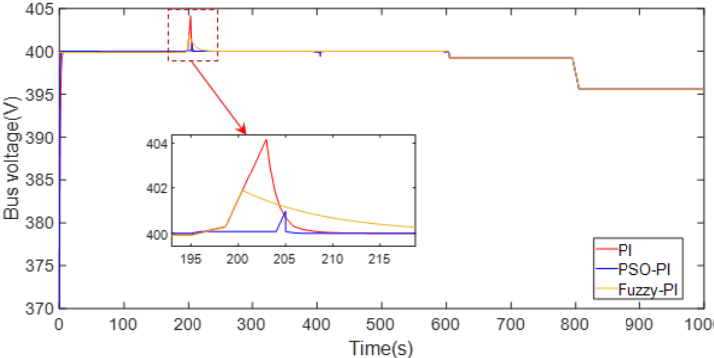
Figure 14. Bus voltage without AA-CAES in Example 1.